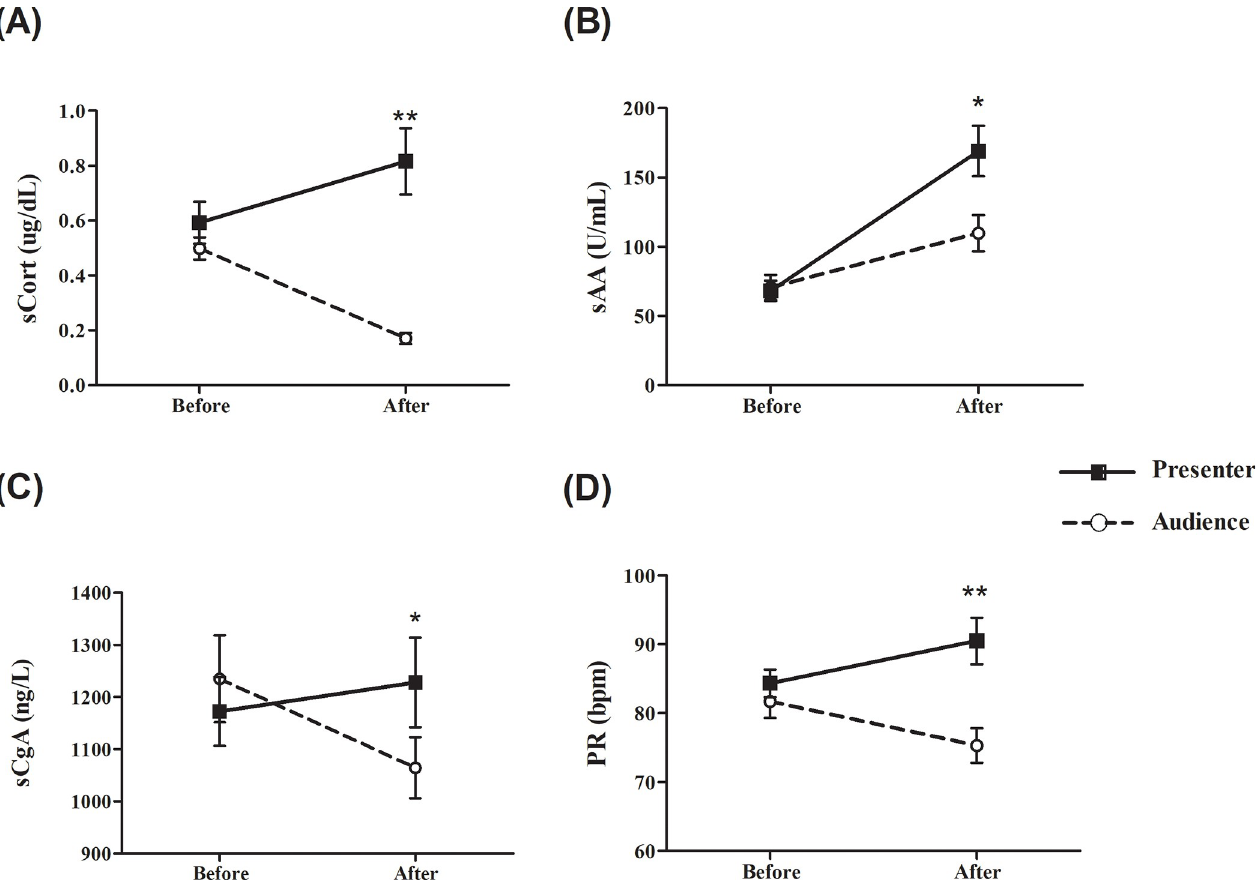
Fig 1. The levels of salivary biomarkers and pulse rate before class and after oral presentation (in presenters) or during class (in audience). Data were presented as mean ± SEM of salivary cortisol (A), salivary alpha-amylase (B), salivary chromogranin A (C) levels, and pulse rate (D). � p < 0.05 and �� p < 0.001 compared with